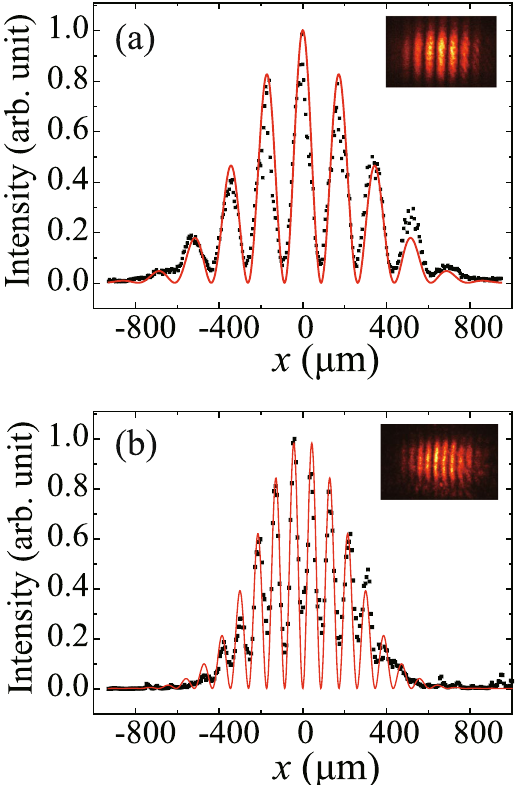
Figure 2. The transverse intensity profiles of the interference pattern for the input signal field E S ( a ) and the retrieved output signal field E S ′ with an effective wavelength of λ /2 ( b ) in the rear focal plane of lens L1. The slit width a and the separation distance d of the double-slit are 200 μ m and 1000 μ m, respectively. The insets show the corresponding intensity distribution recorded by ICCD through lens L2. The black squares are the experimental data, and the red solid curves are theoretical simulation using Eq. (2) for ( a ) and Eq. (3) for ( b ), respectively, with experimental parameters and without any fitting